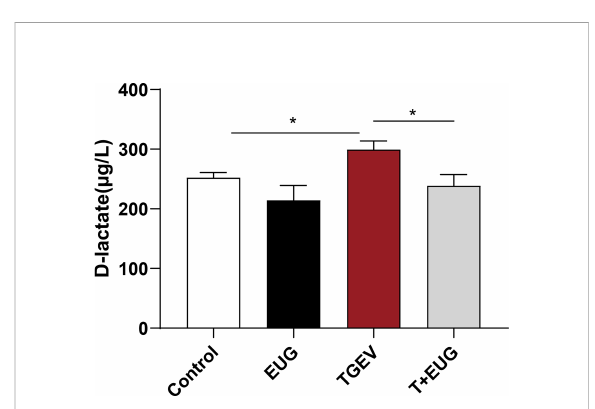
FIGURE 6 Effects of eugenol on serum D-lactic acid concentrations in TGEV- infected weaned piglets. The levels of D-lactic acid in serum were detected by ELISA. Data were expressed as mean ± SEM. * p <